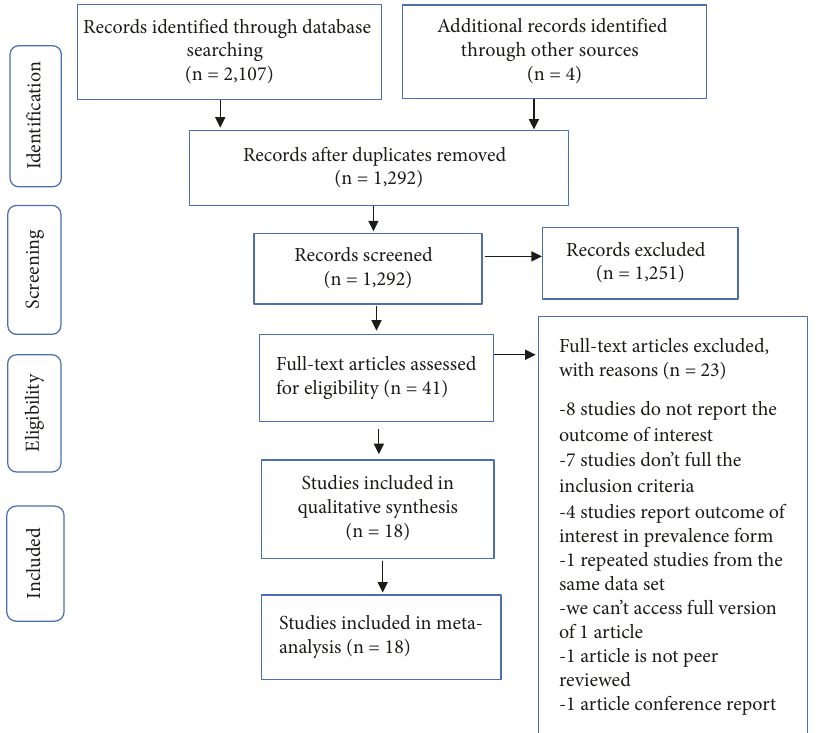
Figure 1: Flow chart describing the selection of studies.